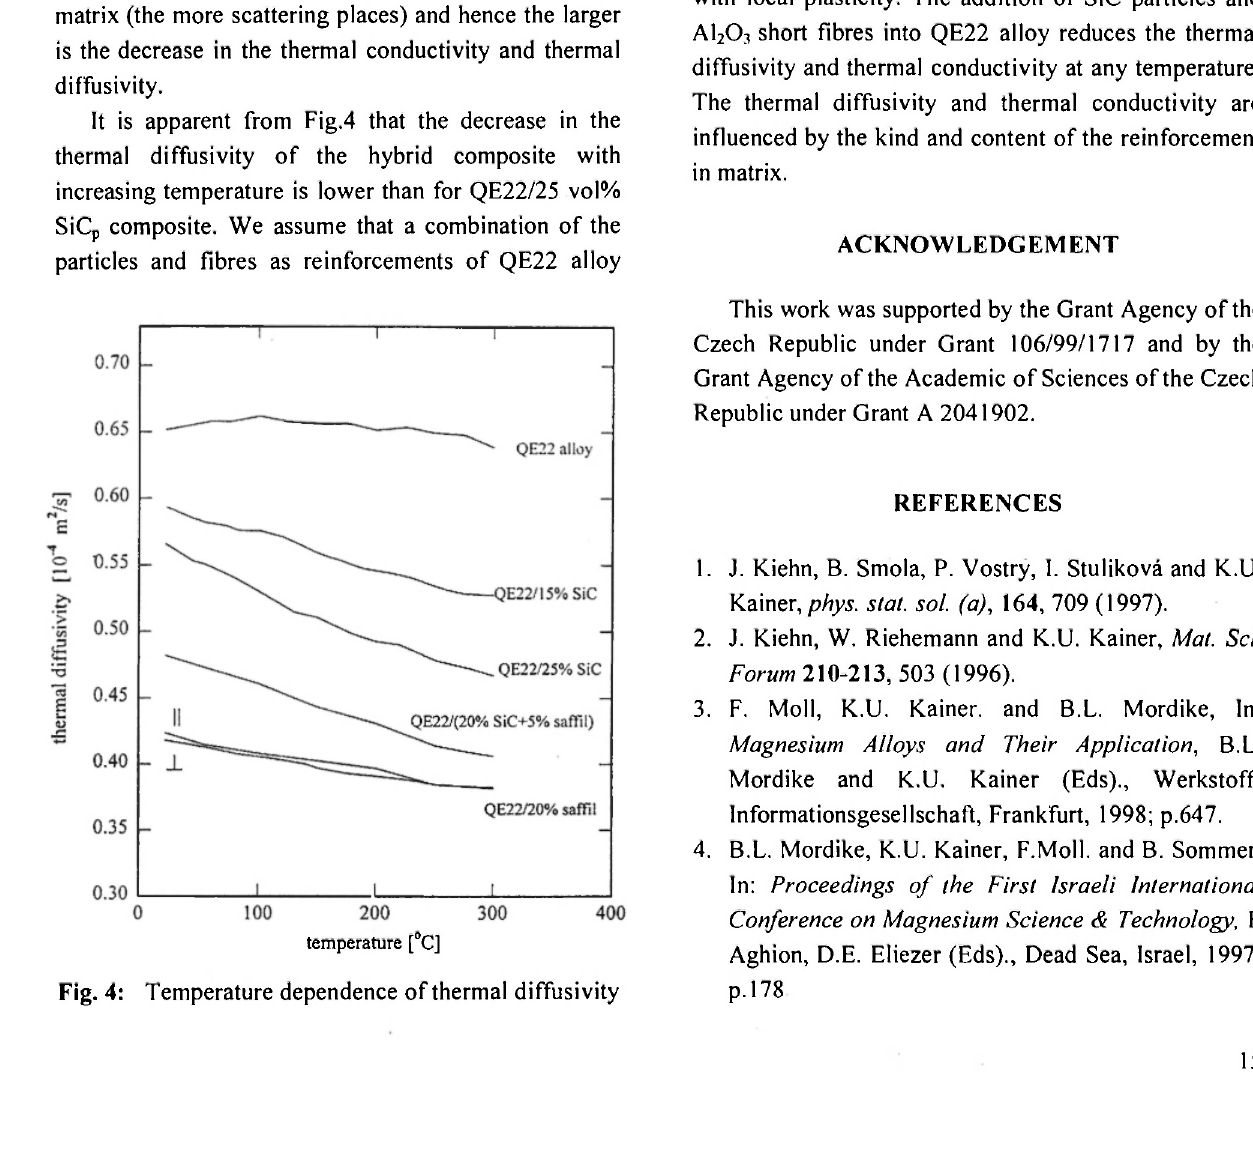
Fig. 4: Temperature dependence of thermal